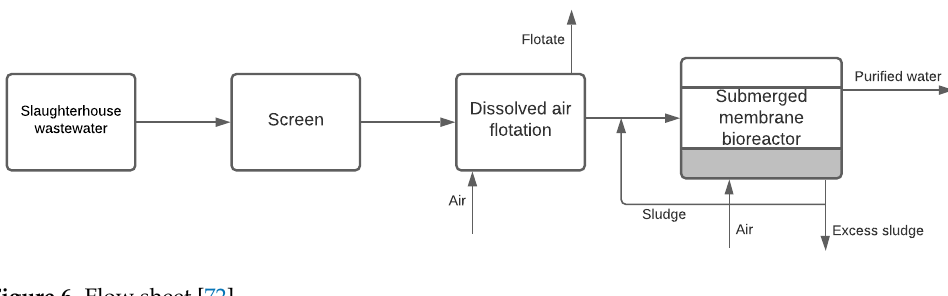
Figure 6. Flow sheet